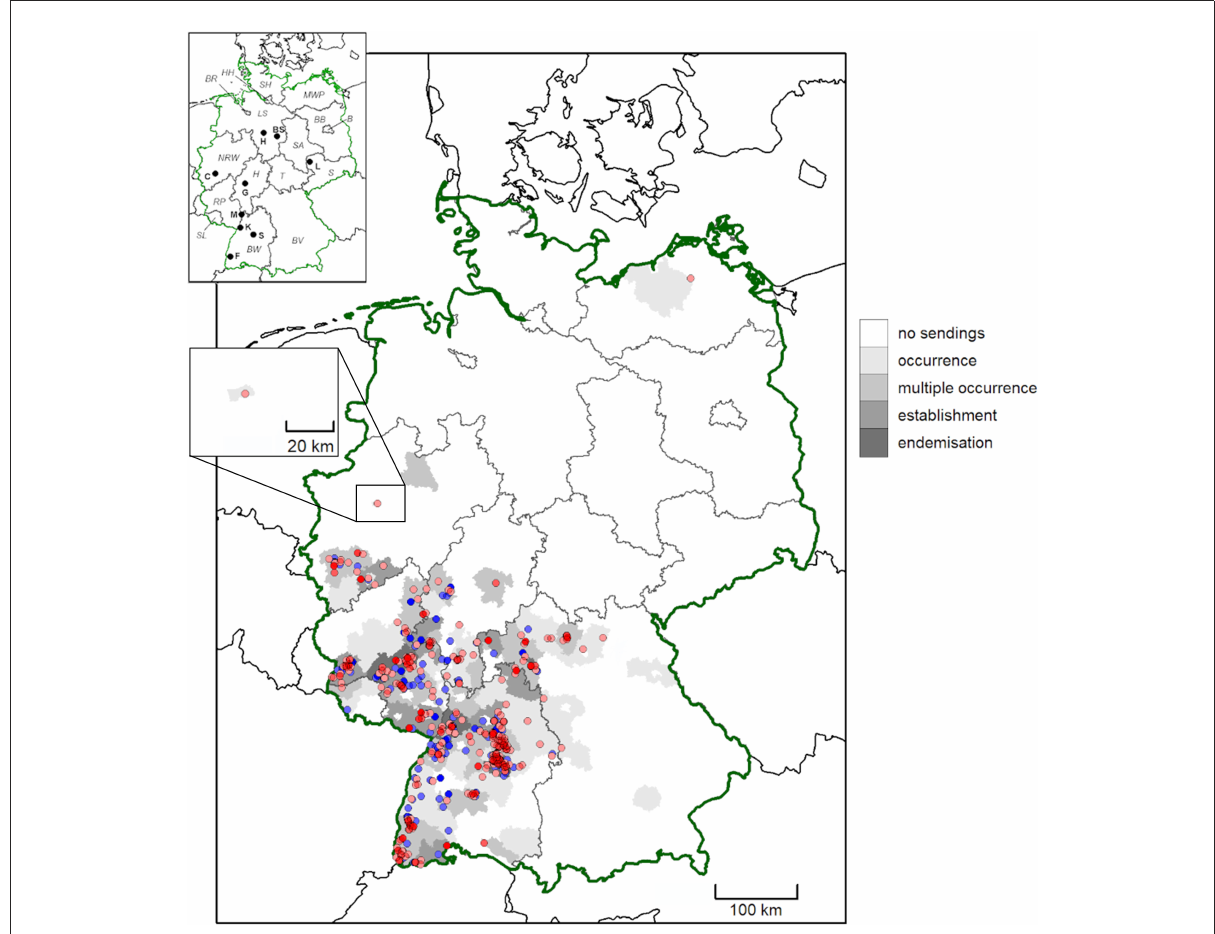
FIGURE2 Geographic origin of D. marginatus submissions from German citizens between February 2019 and May 2021. Districts are shaded according to evidence for tick occurrence (single tick/location), multiple occurrence (2–5 ticks/location), establishment ( > 5 ticks/location) and endemisation ( > 5 ticks/location, from multiple years). High and medium accuracy records are depicted as dots. Locations previously published by Drehmann et al. (10) are shown in blue, while new records are shown in red. More intense colors indicate multiple findings in close proximity. In the map insert, federal states are abbreviated with italic letters (B, Berlin; BR, Bremen; BW, Baden-Wuerttemberg; BV, Bavaria; BB, Brandenburg; HH, Free and Hanseatic city of Hamburg; H, Hesse; LS, Lower Saxony; MWP, Mecklenburg-Western Pomerania; NRW, North Rhine-Westphalia; RP, Rhineland-Palatinate; S, Saxony; SA, Saxony-Anhalt; SH, Schleswig-Holstein; SL, Saarland; T, Thuringia) and cities with bold letters (BS, Brunswick; C, Cologne; F, Freiburg; G, Gießen; H, Hanover; K, Karlsruhe; L, Leipzig; M, Mannheim; S, Stuttgart).